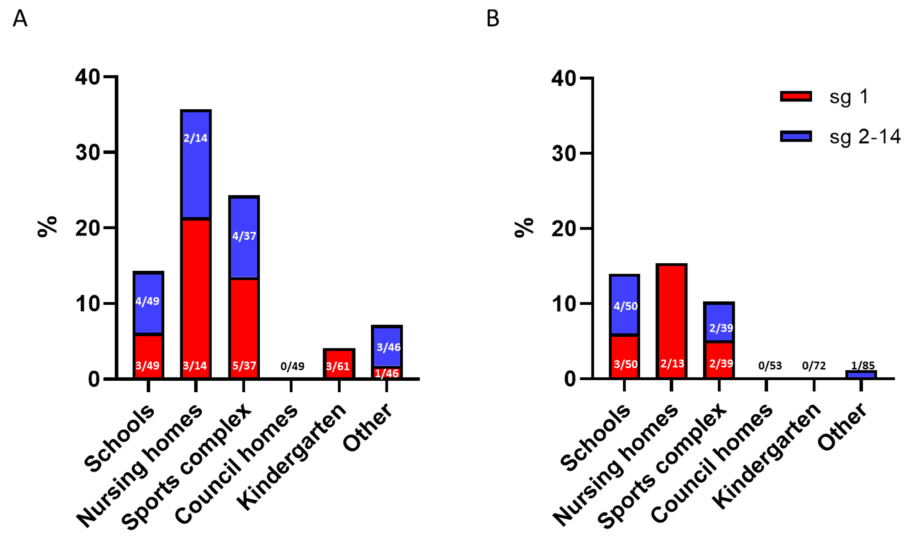
Figure 1. Relative prevalence of L. pneumophila in shower systems in different municipal building types. The y -axis indicates the percentage of L. pneumophila culture-positive shower systems, and the x -axis indicates the different municipal building categories. ( A ) The initial round of sampling. ( B ) The current round of sampling. Red bars represent L. pneumophila sg1, and blue bars represent L. pneumophila sg2–14. The numbers on the bars indicate the actual number of culture-positive shower systems compared to the total number of shower systems